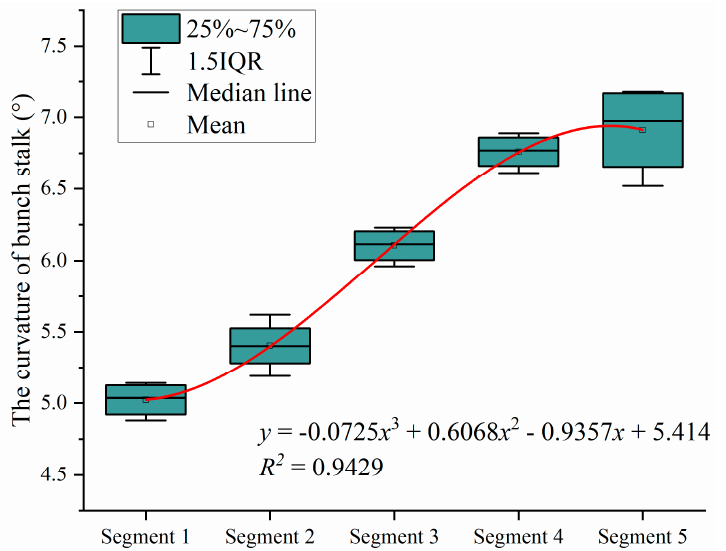
Figure 8. The relationship between the curvature of the bunch stalk and the segments. There are differences in the curvature of bunch stalks of different varieties and seg- ments. For example, in the experimental samples, the average value of the curvature of Brazilian bananas was 4.73% larger than that of plantain bananas. The average value of the curvature of Segment 5 on bunch stalk was about 1.01 times that of Segment 4, the average value of the curvature of Segment 4 was about 1.11 times that of Segment 3, the average value of the curvature of Segment 3 was about 1.13 times that of Segment 2, and the average value of the curvature of Segment 2 was about 1.08 times that of Segment 1. According to the relationship model between the experimental factors and the curvature of bunch stalks, we found that the minimum, maximum, and average values of the curva-